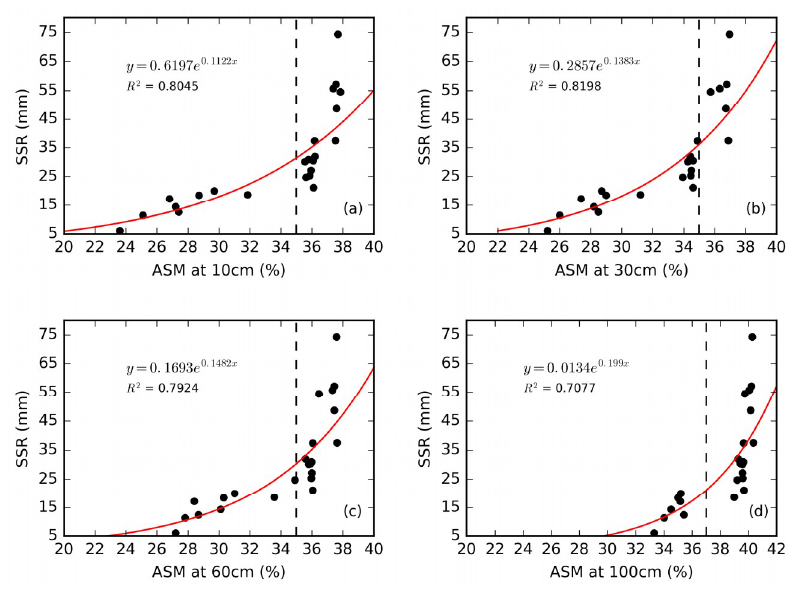
Figure 7. Relationship between SSR (Subsurface Runoff) and ASM (Antecedent Soil Moisture) at different depths: ( a ) 10 cm; ( b ) 30 cm; ( c ) 60 cm; ( d ) 100 cm. The vertical line highlights the significant change.